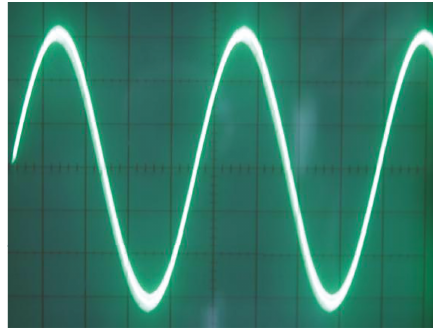
Figure 21: Superimposed signal photo.